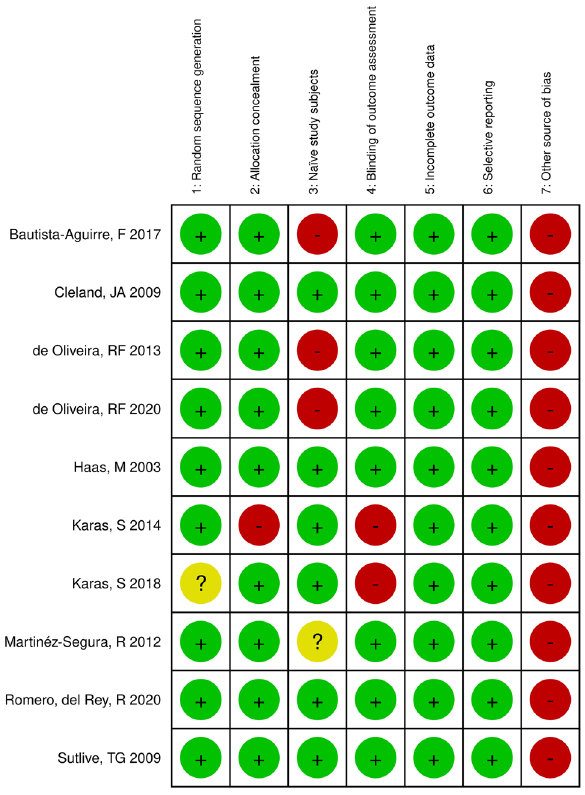
Figure 2. Summary of risk of bias for 10 studies in a systematic review comparing the outcome of applying spinal manipulative therapy at a candidate site versus a non-candidate site. The risk of bias was assessed using a modified version of the Cochrane Risk of Bias Tool for Randomized Controlled Trials. A ‘green + ’ indicates low risk of bias, a ‘red –’ indicates high risk of bias, and a ‘yellow ?’ indicates an unsure risk of bias.